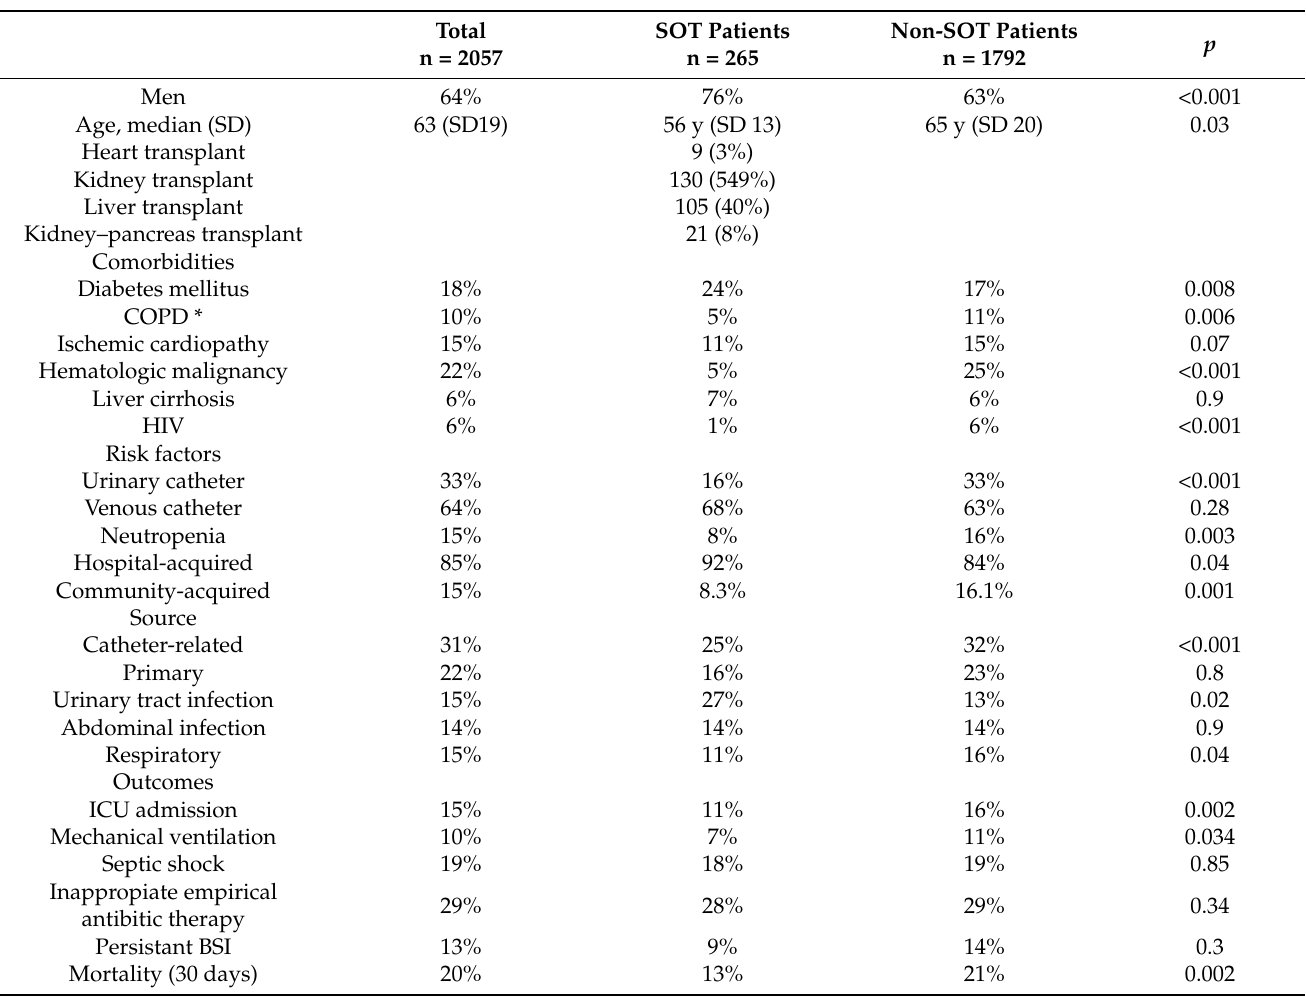
Table 4. Demographics and clinical characteristics of the cases with P. aeruginosa BSI and their outcomes in solid organ transplant recipients. Total SOT Patients Non-SOT Patients n = 2057 n = 265 n = 1792